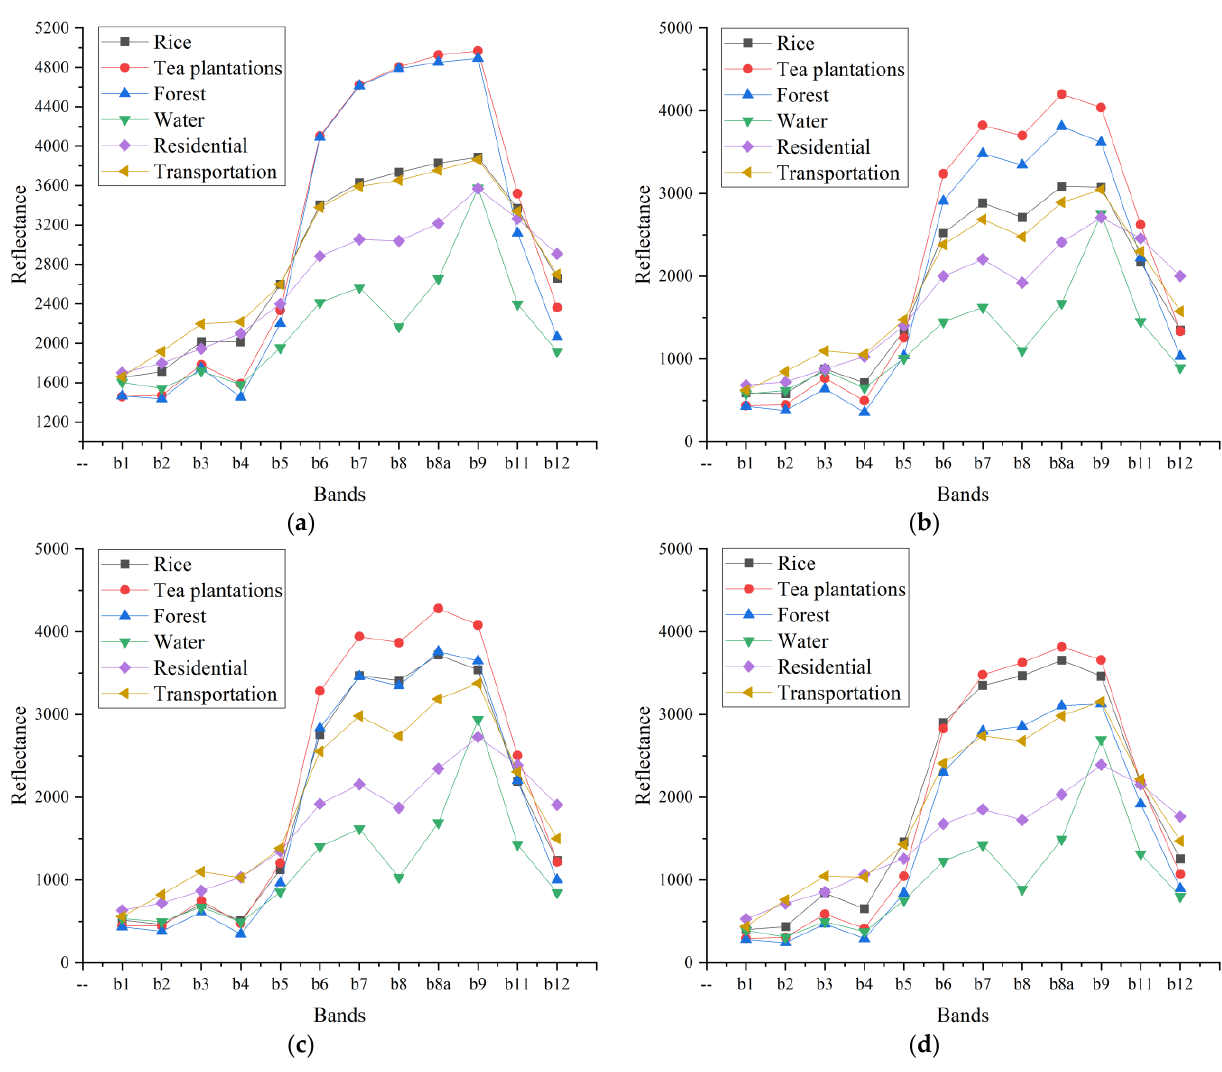
Figure 5. Spectral curves of land types in different growth stages of rice. ( a ) Seeding period, ( b ) joining period, ( c ) heading period, and ( d ) maturity period. Table 3. Kurtosis and skewness of features in different